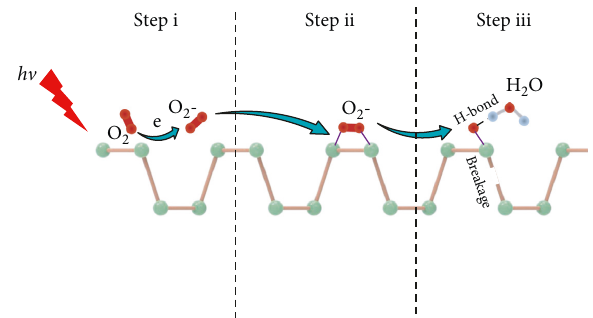
Figure 3: The degradation mechanism of